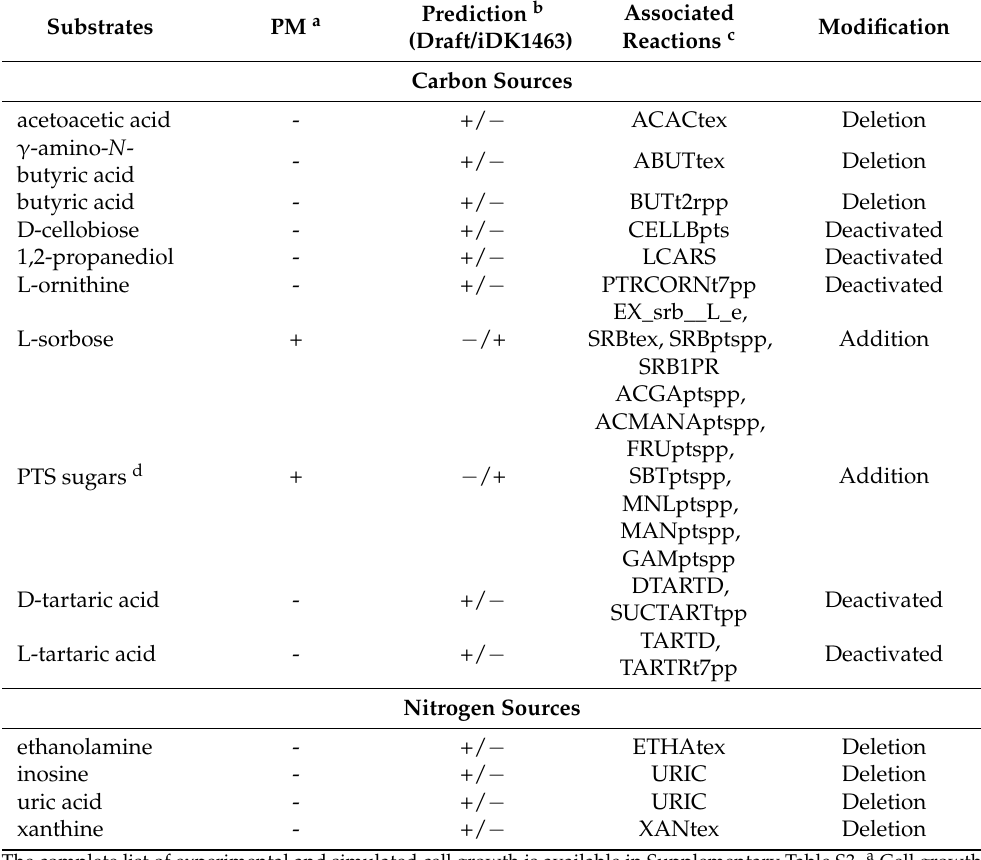
Table 1. Model refinement based on comparison of the simulated and experimental